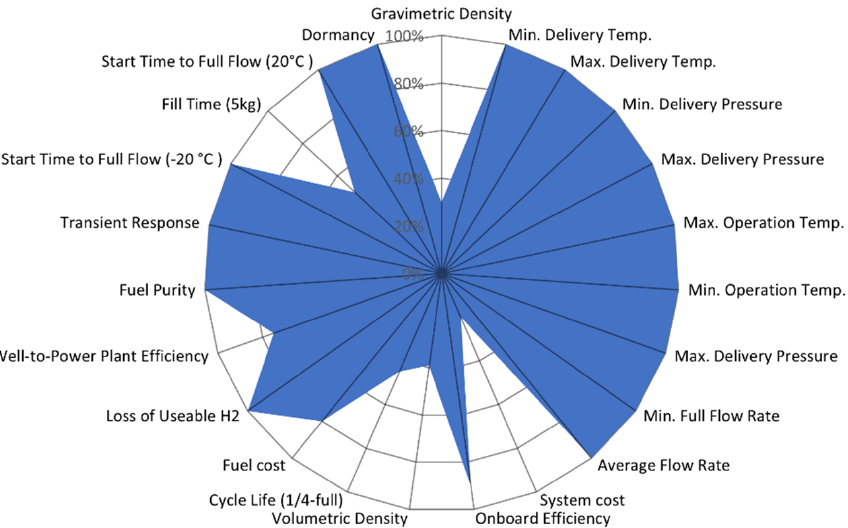
Figure 10. Projected sodium alanate (SAH) system compared against 2020 targets, dual tank, from DOE [105].